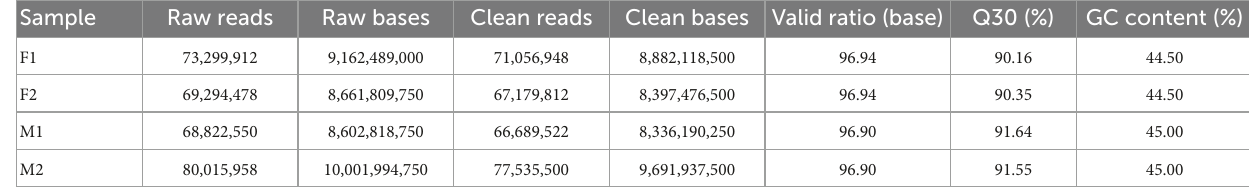
TABLE 1 Results of quality pretreatment.